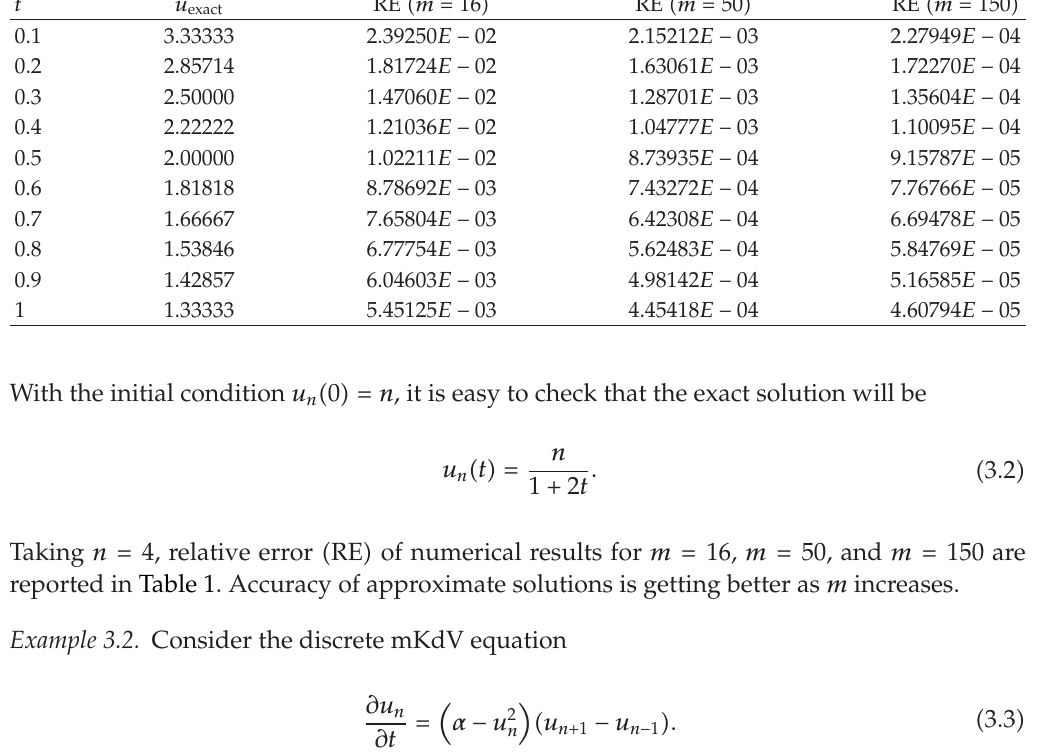
Table 1: Relative errors of u